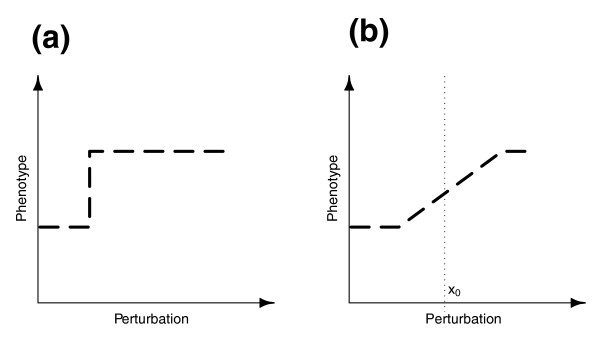
Response types. (a) Binary response. Above a certain threshold of perturbation, a discrete phenotype can be observed. (b) Continuous response. The effect size of the phenotype correlates with the amount of perturbation. It is typically measured for mild perturbation levels (x0).